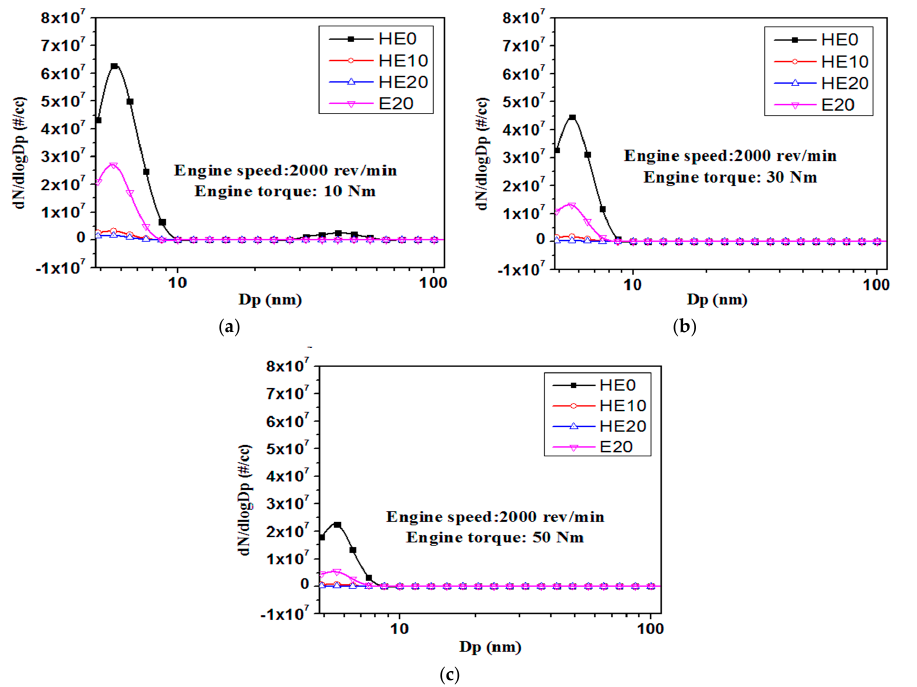
Figure 4. Size distribution of particles for ethanol blends at a 2000 rev/min engine speed and ( a ) 10 Nm; ( b ) 30 Nm; ( c ) 50 Nm engine loads. Energies 2017 , 10 , 1263